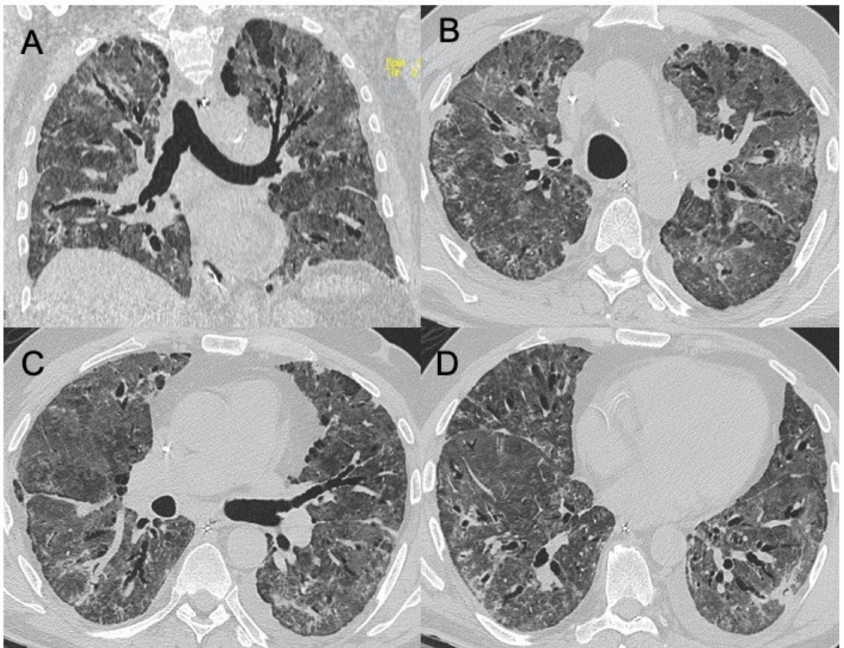
Figure 4. H1N1 interstitial pneumonia. These images ( A – D ) show a case of H1N1 related-pneumonia complicated in acute respiratory distress syndrome (ARDS), with diffuse and bilateral ground-glass opacities and traction bronchiectasis/bronchiolectasis.